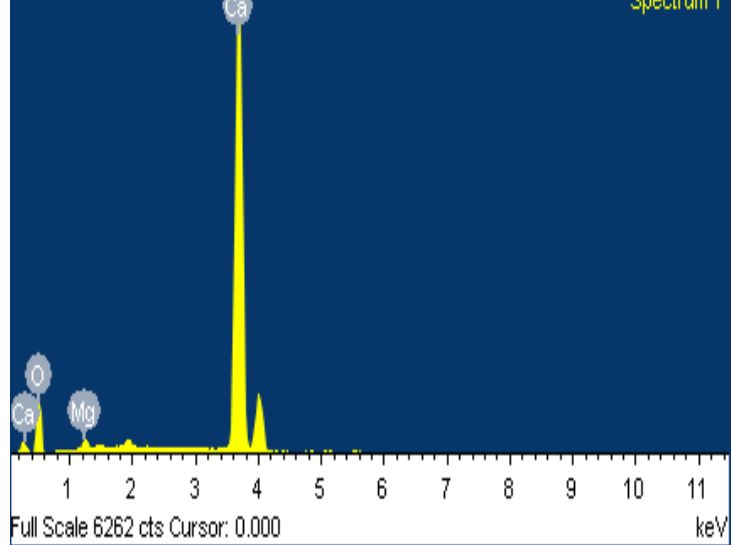
Figure 2. Substance analysis results of calcium hydroxide with EDS.